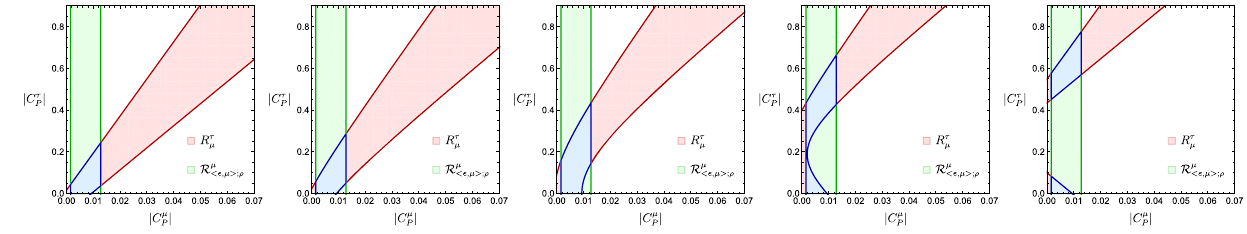
μ | – | C τ | plane for φ μ = 0 ◦ and different values of φ τ P P P